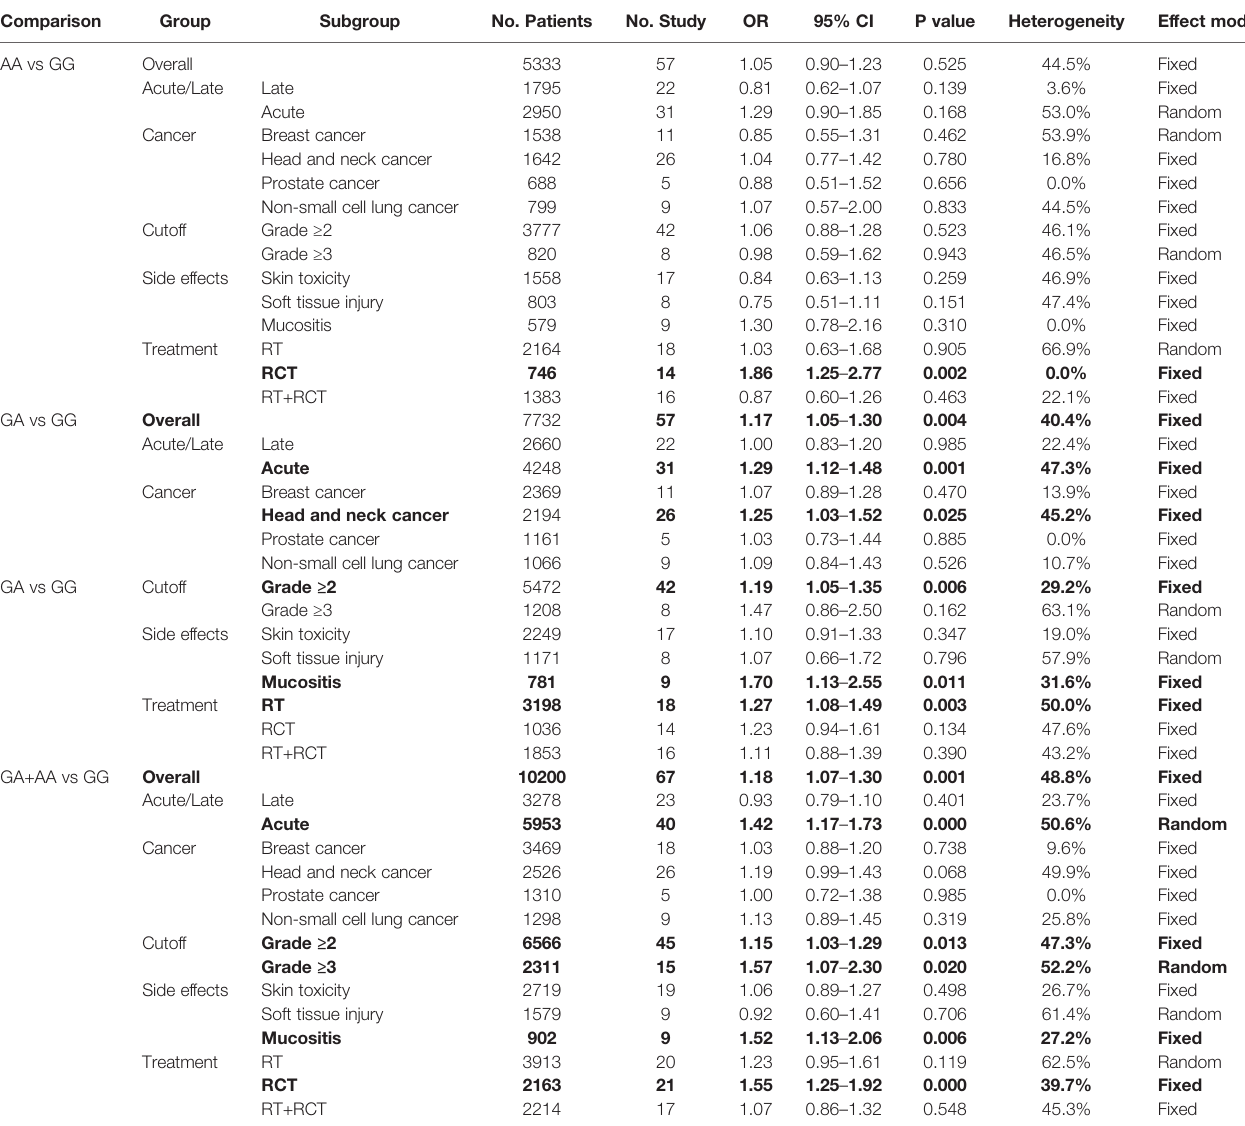
TABLE 4 | Overall and subgroup analysis for relation between XRCC1 rs25487 and side effects. Comparison